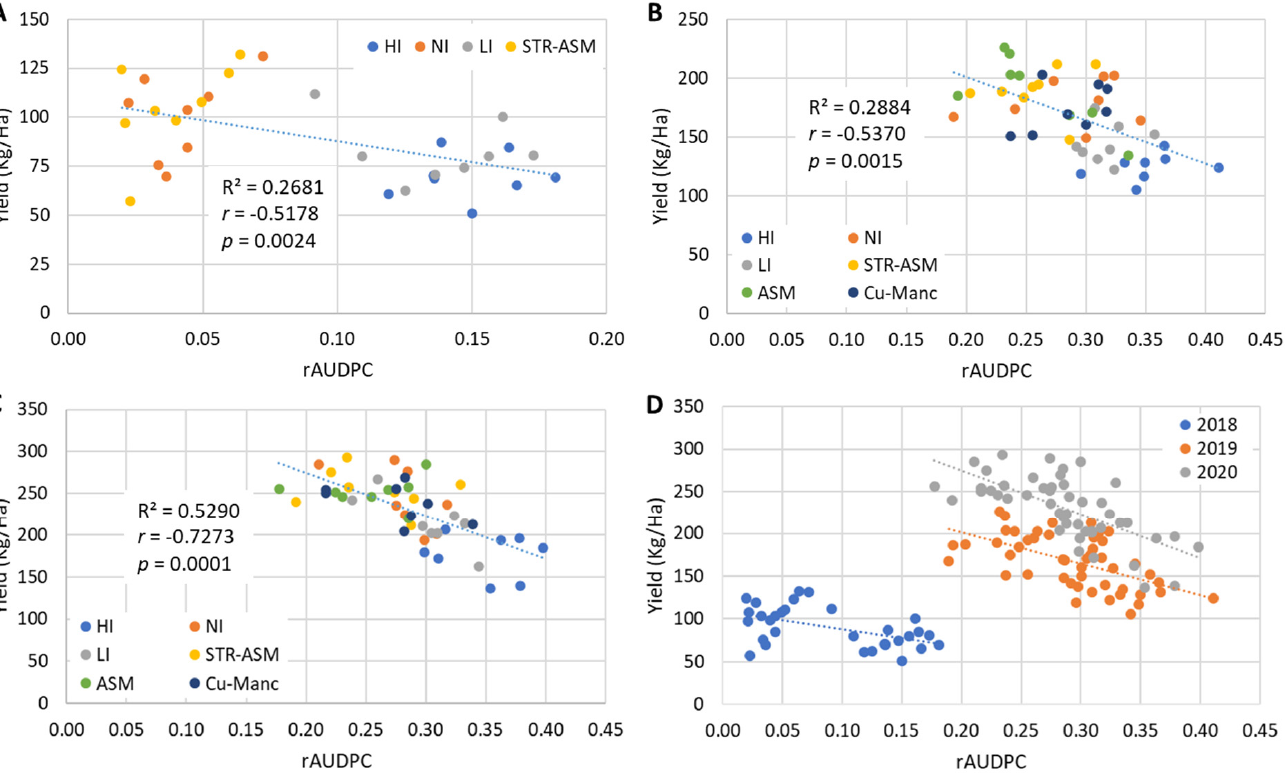
Figure 3. Correlation of bacterial spot disease progression based on relative area under disease progress curve (rAUDPC) to marketable yield across bactericide treatments during individual trials conducted in ( A ) 2018, ( B ) 2019, ( C ) 2020 and ( D ) across all seasons. Plot treatments included three inoculation treatments and three bactericide treatments. Inoculation treatments included a non-inoculated (NI) control and low inoculum (LI) and high inoculum (HI) treatments in which plots were inoculated either once after transplanting or were reinoculated every two weeks for six weeks after transplanting, respectively. The three bactericide treatments relied on natural inoculum movement from inoculated plots and included weekly applications of acibenzolar-lar-S-methyl (ASM), streptomycin sulfate + ASM (STR+ASM), or copper hydroxide + mancozeb (Cu-Manc). Linear trendlines were included for each trial, along with the corresponding coefficient of determination (R 2 ), Pearson’s correlation ( r ), and statistical significance ( p ). Table 2. Average application costs for each bactericide treatment in USD/ha by